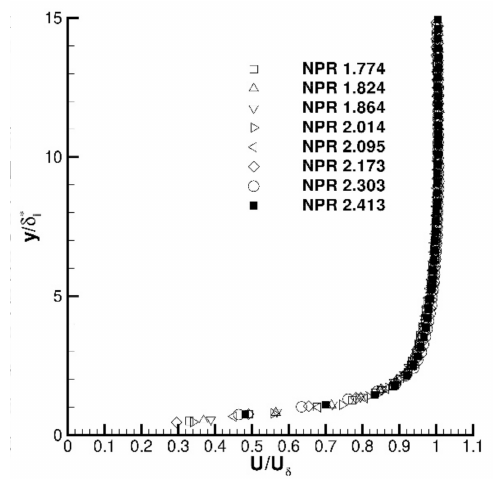
Figure 12. LU48 nozzle exit profiles NPR = 1.77–2.41. Figure 13 examines LDA data for turbulence Reynolds stresses in the nozzle exit boundary layer.